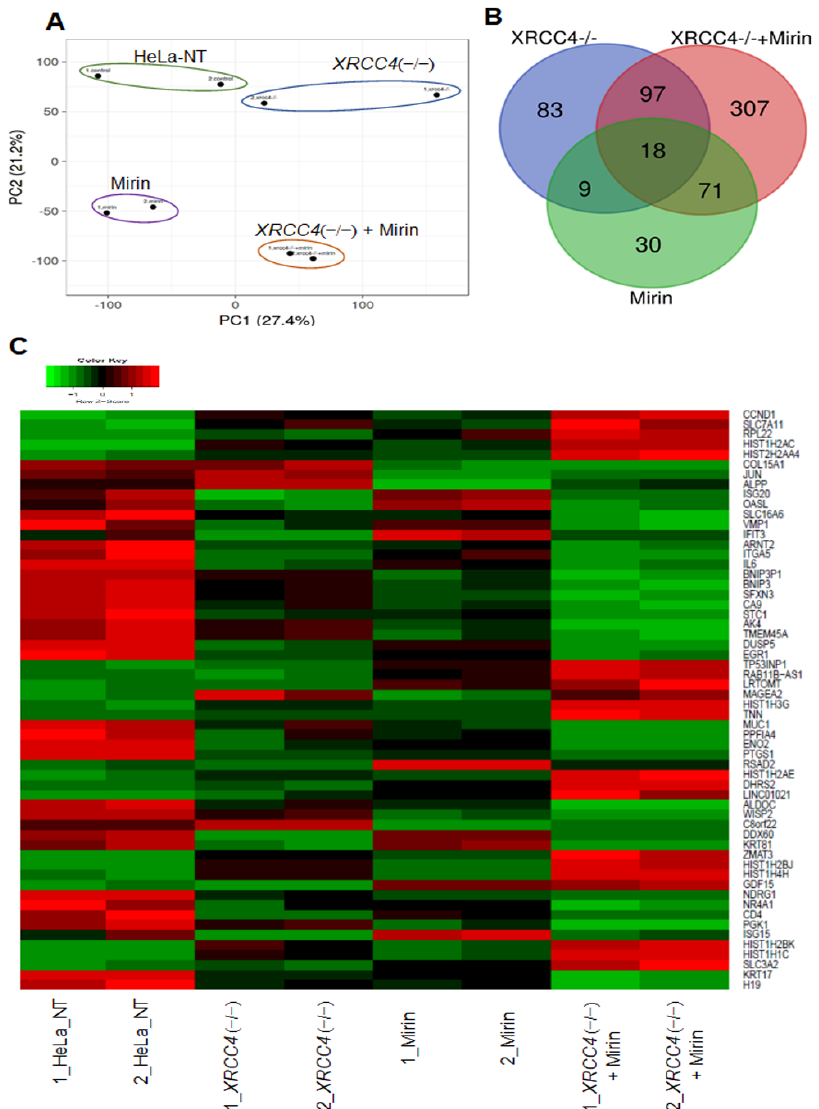
Figure 5. Principal component analysis (PCA), Venn diagram, and heatmap from RNA-seq profile. ( A ) A PCA plot for HeLa-NT, XRCC4 knockout, mirin-treated, and XRCC4 knockout + mirin-treated samples from whole-transcriptome RNA-seq data using ClusVis [32]. ( B ) A Venn diagram representing shared and unique differentially expressed genes (DEGs) across three categories: (i) XRCC4 knockout cells (blue) (ii) mirin treated (green) (iii) XRCC4 knockout with mirin treated (red) when compared to HeLa-NT cells. ( C ) A heatmap of top DEGs across each sample categories. Knockout = KO. The analyses are based on duplicate experiments.